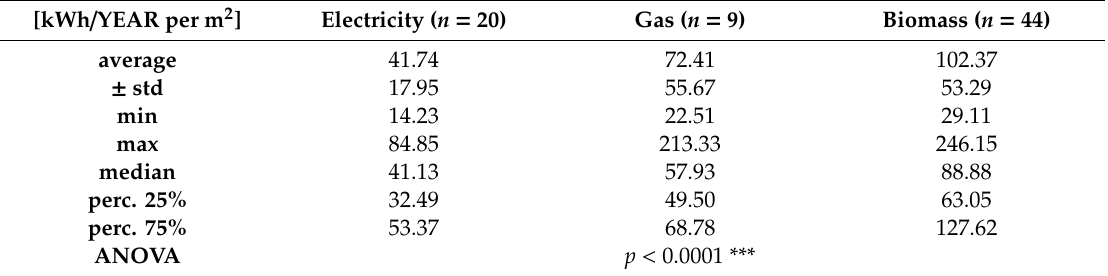
Table 10. Annual energy demand for heating categorized according to heating medium type calculated per m 2 of useful floor area of the analyzed wood constructions regardless of the construction system.